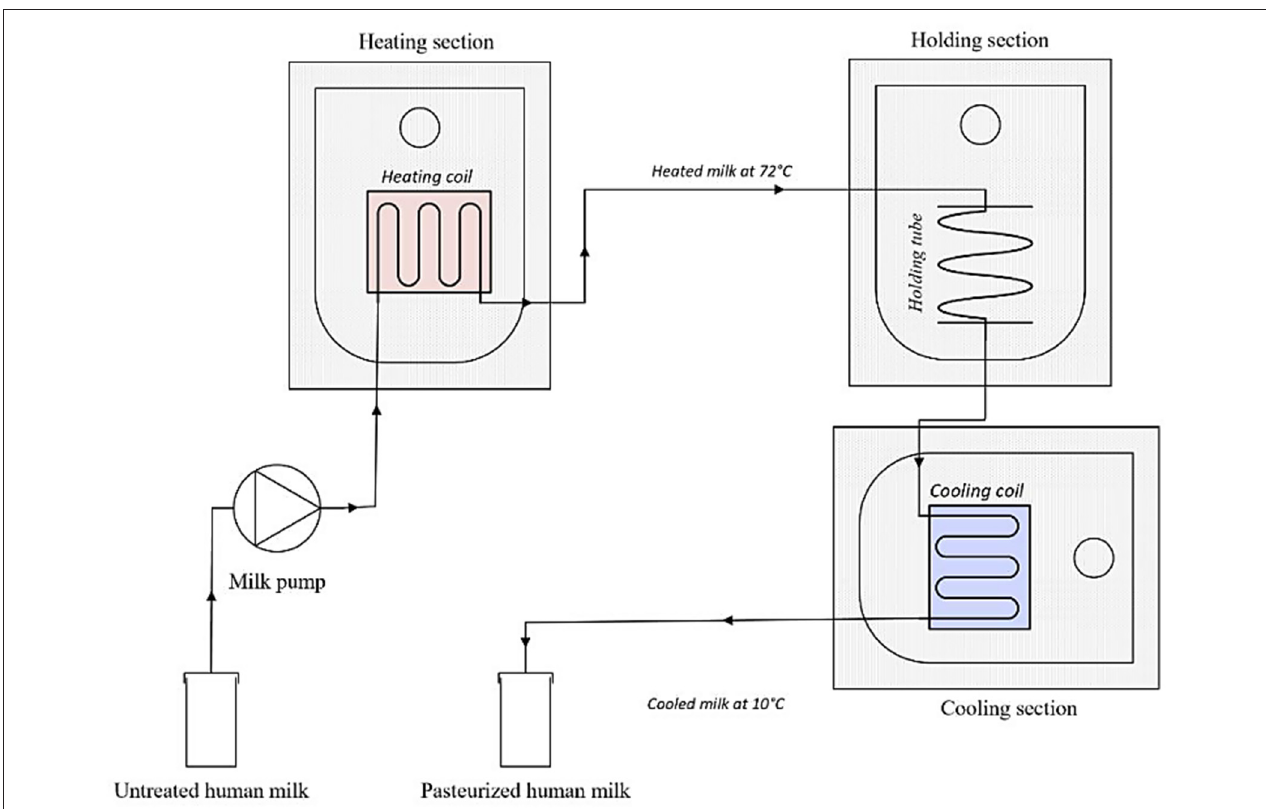
FIGURE 2 | Schematic representation of the HTST system set-up.